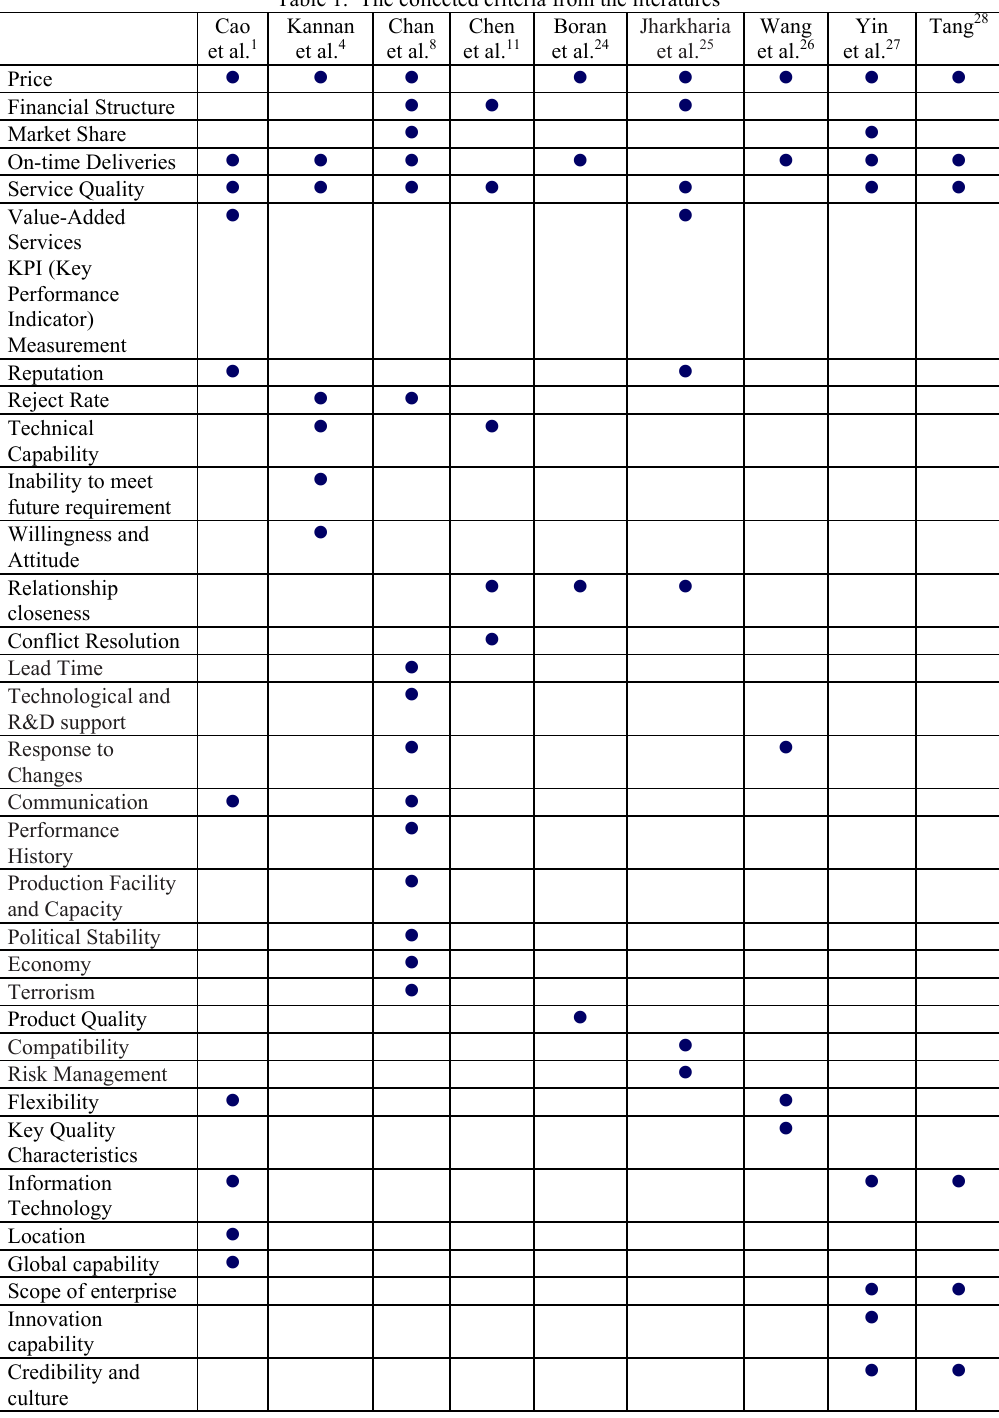
Table 1. The collected criteria from the